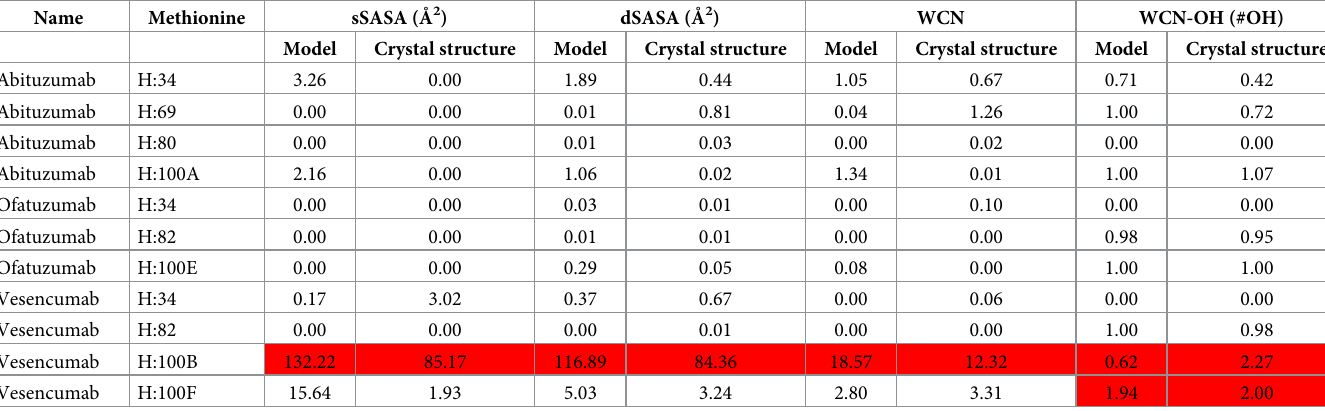
Table 2. Comparison of in silico prediction of oxidation events based on homology models and crystal structures.